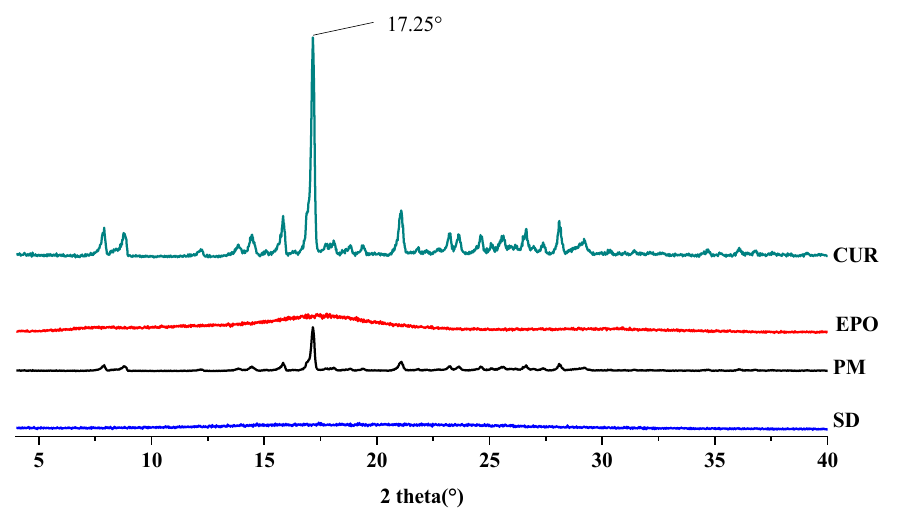
Figure 8. The XRD diffraction patterns of samples.